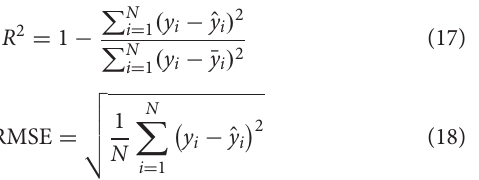
Frontiers in Neuroscience |